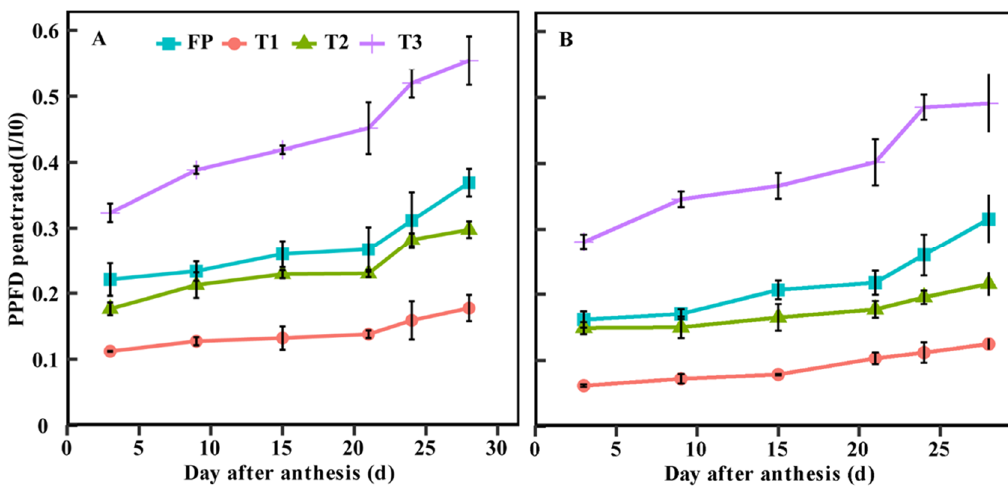
Figure 4. Relative photosynthetically active photon flux density (PPFD) penetrated of the top three leaves ( A ) and whole